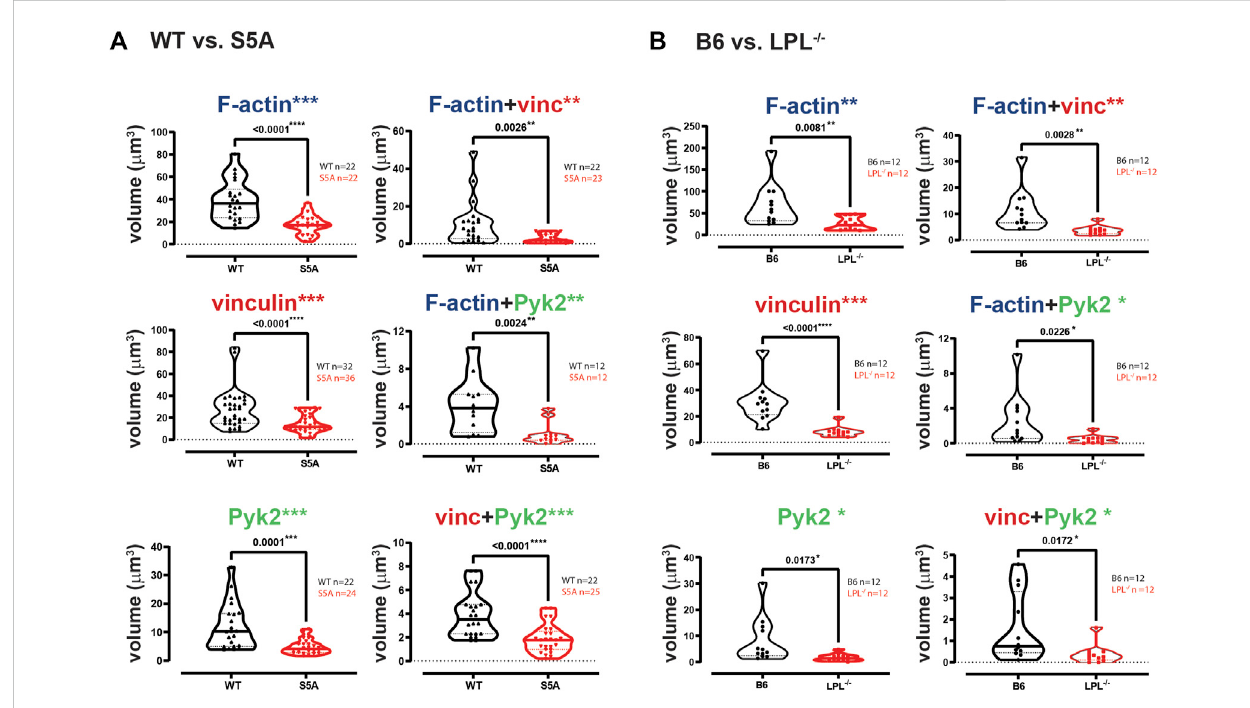
FIGURE 7 Quanti fi cation of volumes of protein aggregates reveals loss of vinculin and Pyk2 from podosomes in AMs expressing S5A-LPL or AMs lacking LPL. Imaris software was used to calculate the total volume ( μ m 3 ) of the indicated protein 3D aggregates contributing to podosome formation after 60 min incubationofAMsderivedfrom (A) matchedWTandS5Amiceor (B) matchedB6andLPL − / − mice(ImagesinFigure6).Eachsymbolrepresentsthevolume calculated from one fi xed cell; n = number of cells analyzed. Images acquired from two independent experiments. p -values determined by Mann- Whitney; * p < 0.05, ** p < 0.01, *** p <